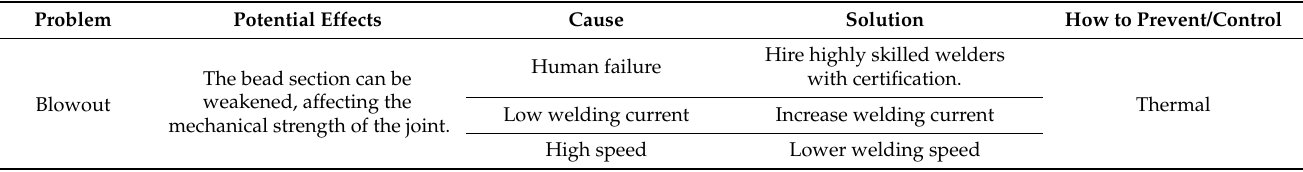
Table 2. How to prevent laser welding defects—during welding